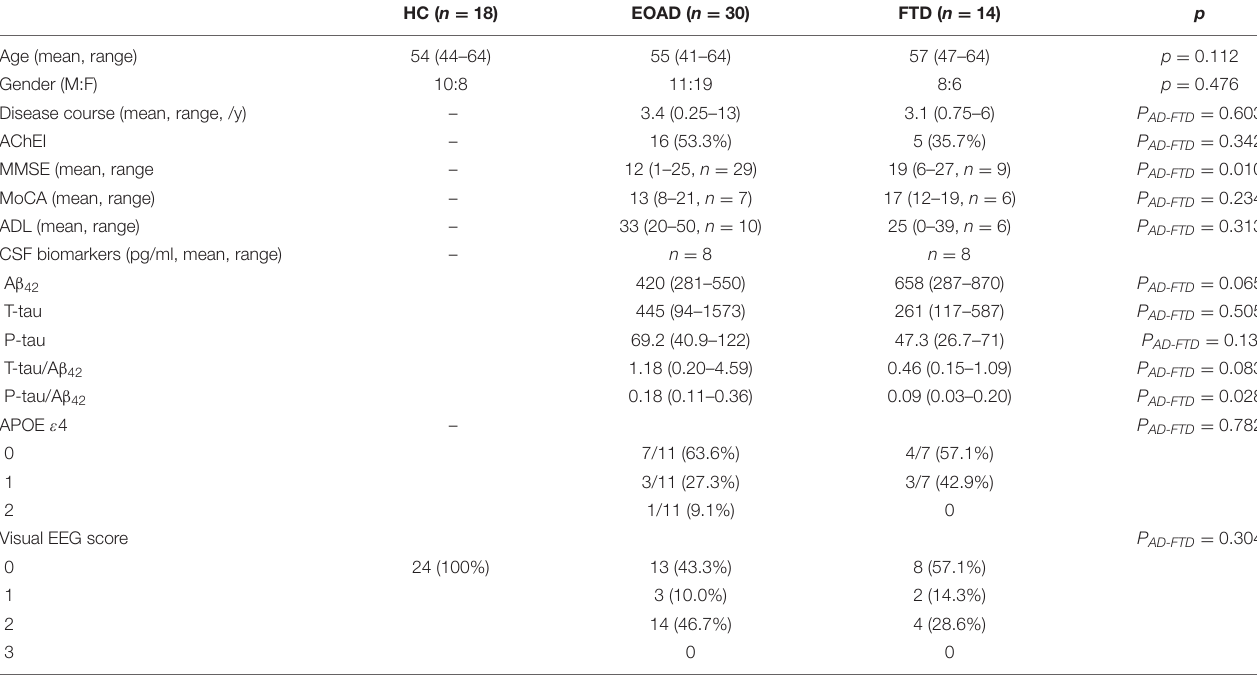
TABLE 2 | Demographic, clinical data, and CSF biomarkers in dementia and control groups.